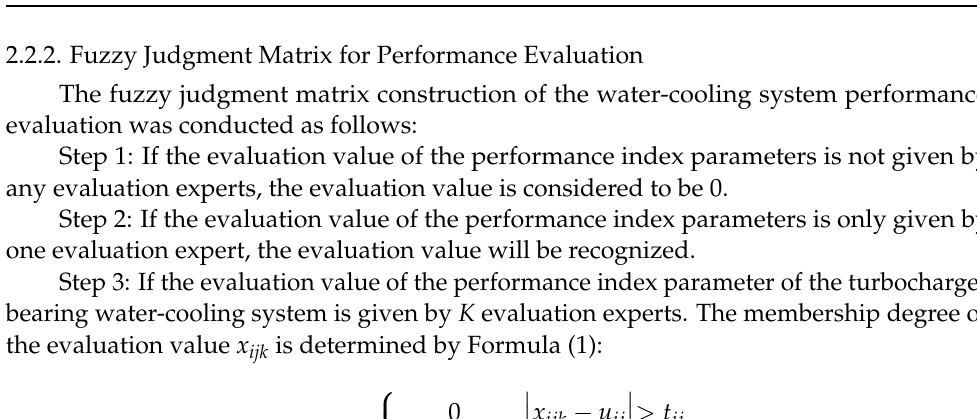
Table 3. Performance index scoring range of the water-cooling system of the turbocharger. Level Excellent Good Fair Fairly Bad Bad Evaluation score 0.90~1.0